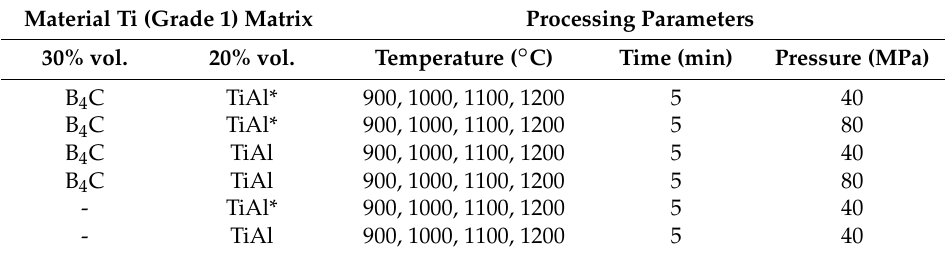
Table 2. Starting composition 1 of titanium matrix composites (TMCs) and the fabrication parameters (by iHP). Material Ti (Grade 1) Matrix Processing Parameters 30% vol. 20% vol. Temperature ( ◦ C) Time (min) Pressure (MPa) B 4 C TiAl* 900, 1000, 1100, 1200 40 B 4 C